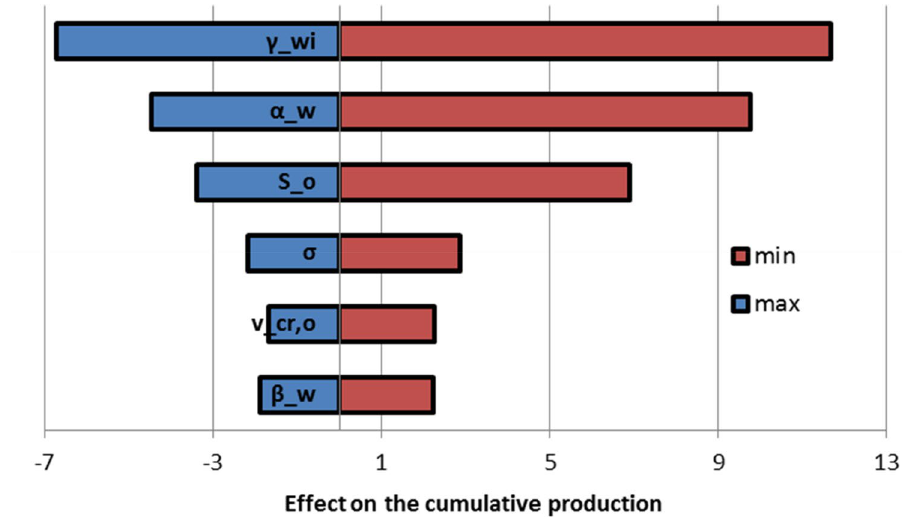
Fig. 16 Tornado diagram showing the effect of the input parameters on the cumulative oil